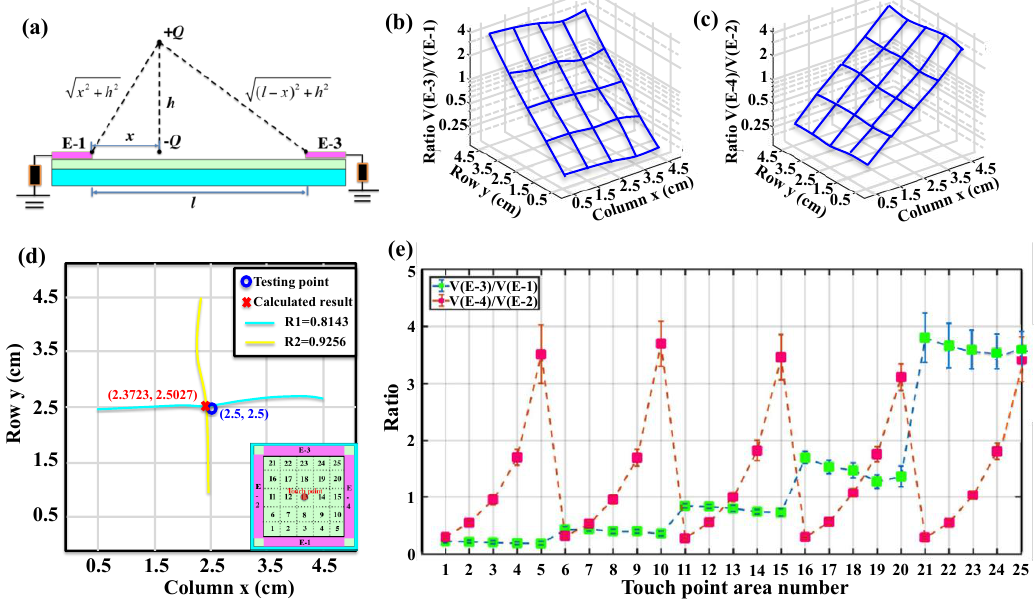
Figure 3. ( a ) The electrostatic analysis of the contact process. The average ratios of ( b ) V (E-3)/ V (E-1) and ( c ) V (E-4)/ V (E-2) at each touch point in semi-log z-axis plot; ( d ) Testing result of touch point (2.5, 2.5), indicating the calculated position and the actual position are highly matched, with deviation less than 1.3 mm. The inset shows the location of the touch point on the device; ( e ) The average values and the standard deviation values of the ratios ( V (E-3)/ V (E-1) and V (E-4)/ V (E-2)) in a sequential order.